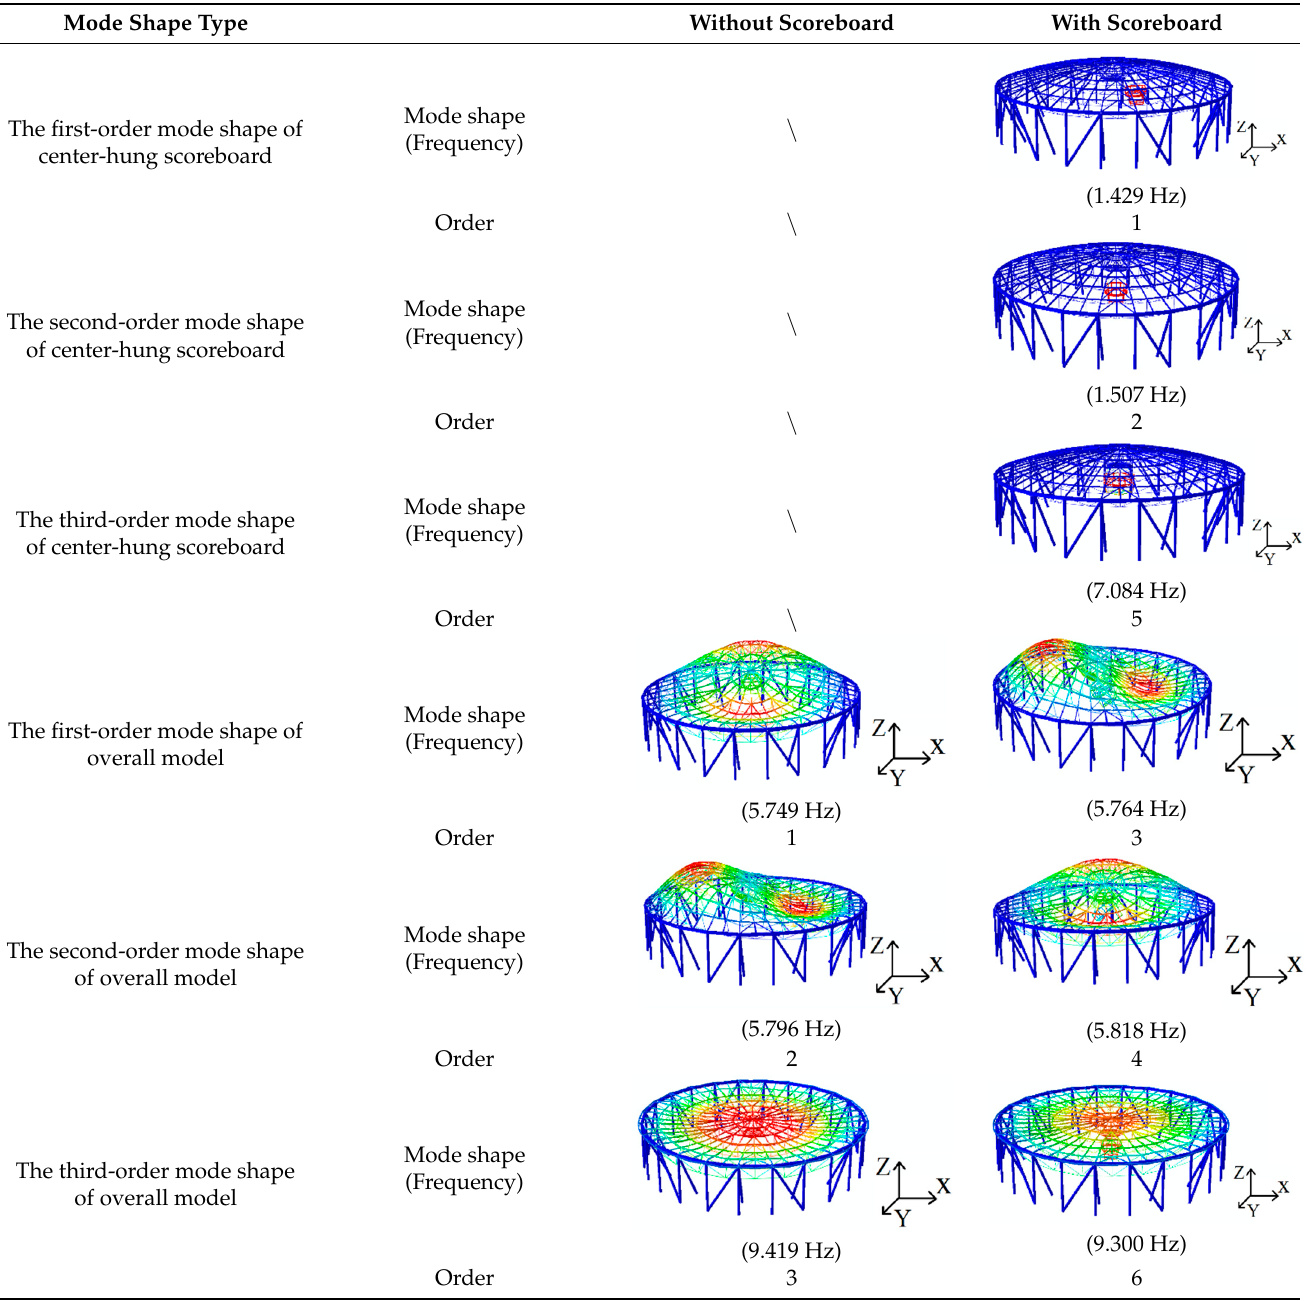
Table 6. Comparison of mode shapes.